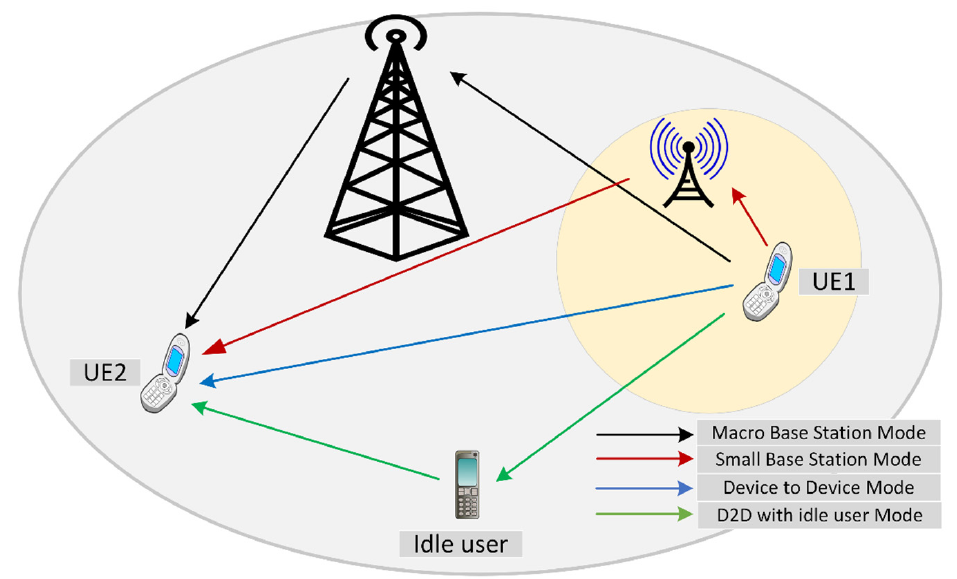
Figure 7. Mode selection in